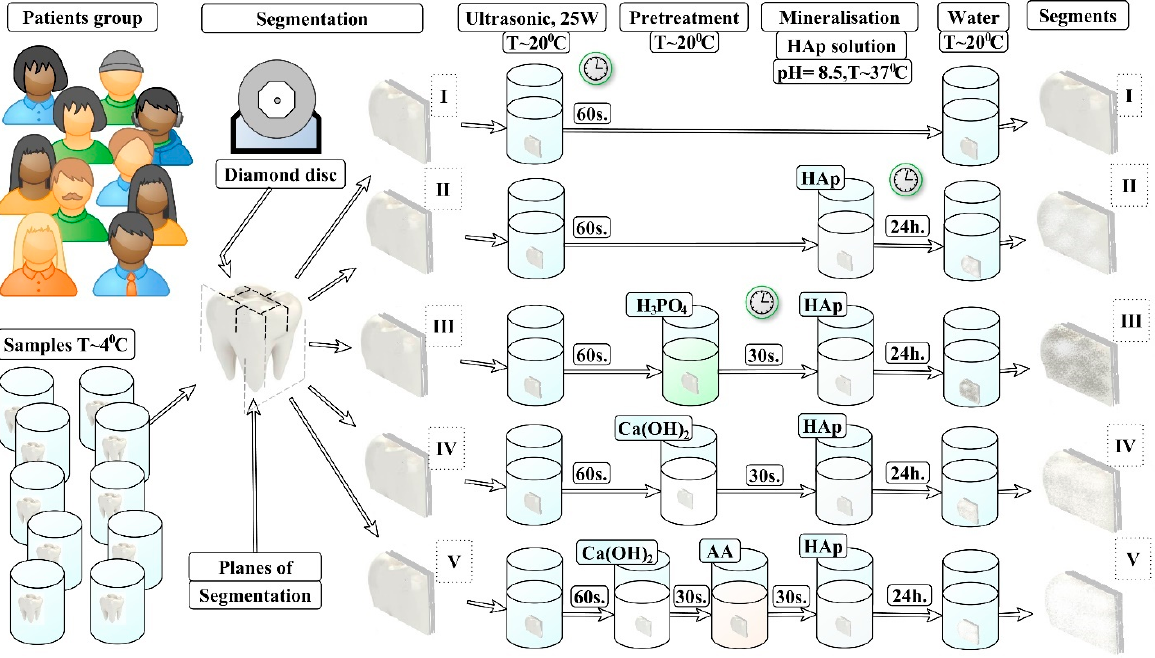
Figure 1. Scheme of ncHAp-based mineralized layer formation under different biotemplate pretreatment conditions. Ⅰ – Ⅴ : type of samples. ment conditions. I – V : type of